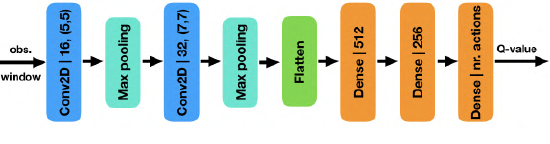
Figure 3. Q-network architecture.